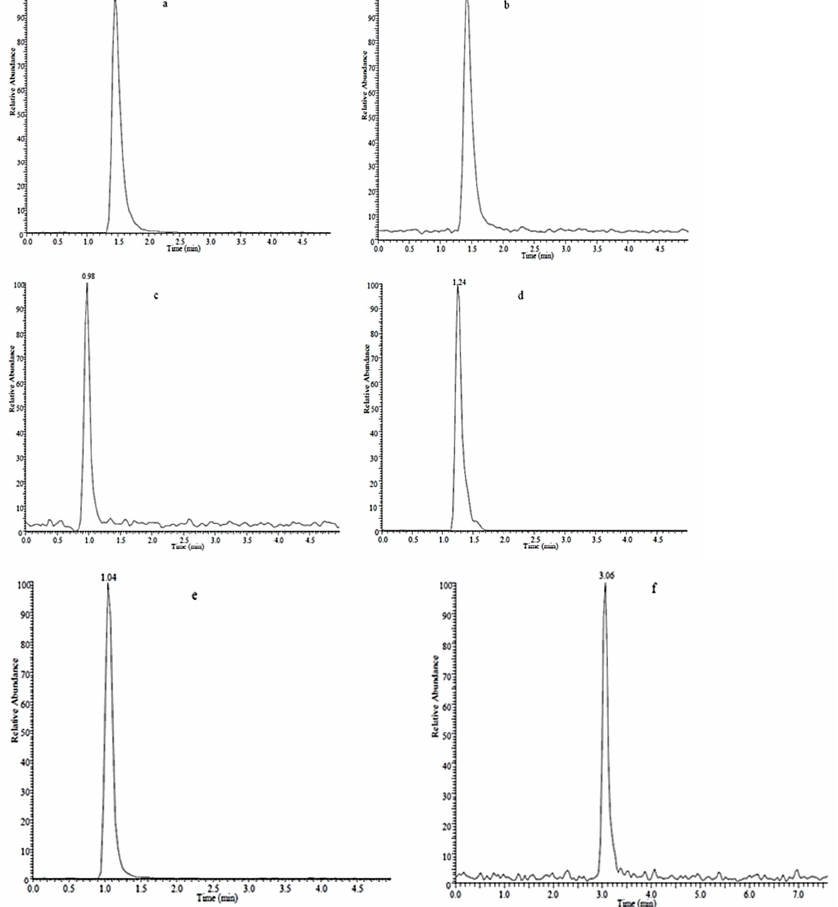
Figure 3. LC reverse phase separation of standard solutions of imidacloprid ( a ), imidacloprid-D4 ( b ), 5-hydroxy imidacloprid ( c ), olefin imidacloprid ( d ), imidacloprid urea ( e ) and 6-chloronicotinic acid ( f